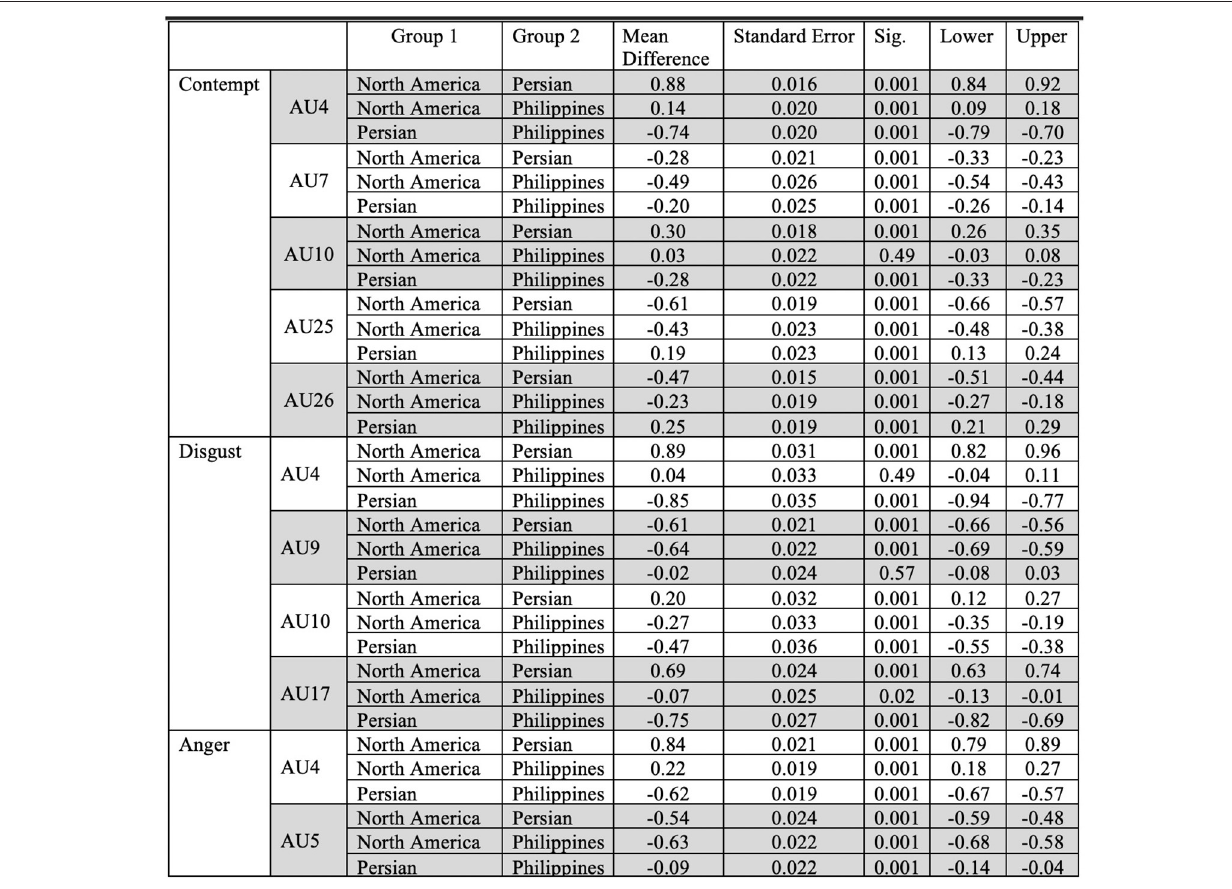
highest testing accuracy was the Filipino data set, with 39%, followed by the Persian data set with